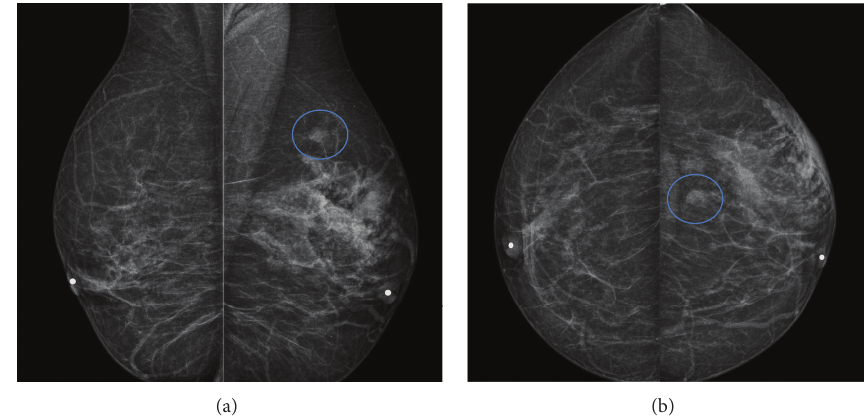
Figure 1: Bilateral mammography : bilateral mediolateral oblique (a) and craniocaudal (b) mammographic views demonstrate scattered fibroglandular tissue with global asymmetry and focal skin thickening in the left breast which was classified as moderate suspicious BI-RADS 4c. There was also an isodense, round, circumscribed mass, measuring 12 × 8 mm in the outer upper quadrant, requiring complementary ultrasonography (encircled). Nipples are